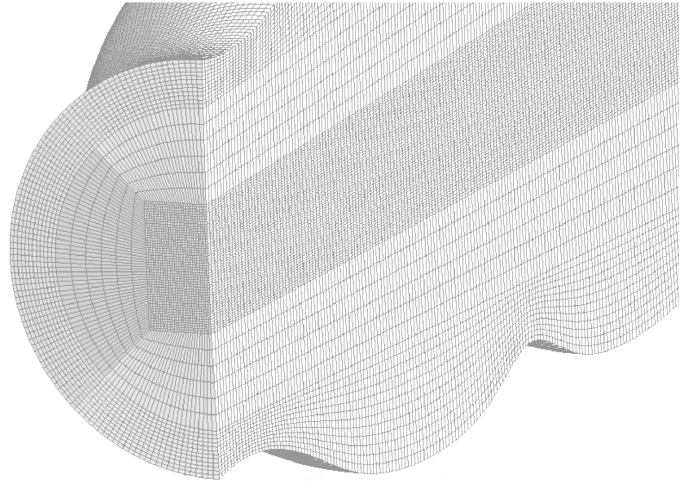
Figure 10. Structured mesh of the rectal lumen model. This type of structured meshing contributes significantly to the stability and convergence of the solution.